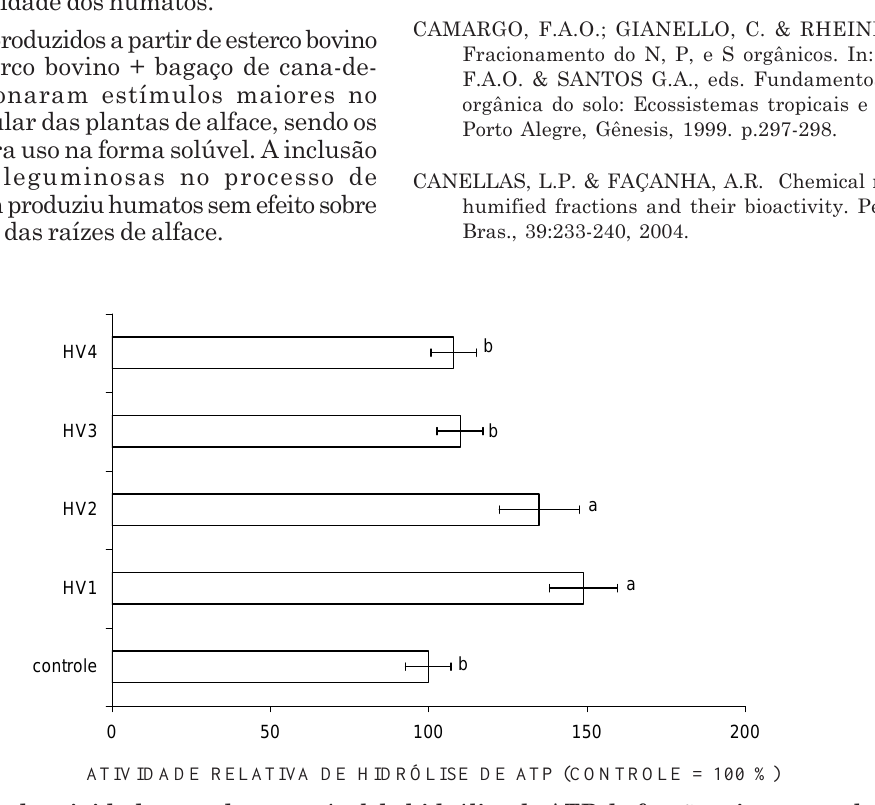
Figura 3. Estímulo da atividade vanadato sensível de hidrólise de ATP da fração microssomal extraída de raízes de alface tratadas com 25 mg L -1 de C de humatos extraídos de vermicomposto de esterco de curral (HV1), de esterco de curral + bagaço de cana de açúcar (HV2), de esterco de curral + folhas de leguminosas (HV3) e de esterco de curral + bagaço de cana de açúcar + folhas de leguminosas (HV4). Os valores das médias são referentes a duas preparações independentes ± desvio-padrão. As médias